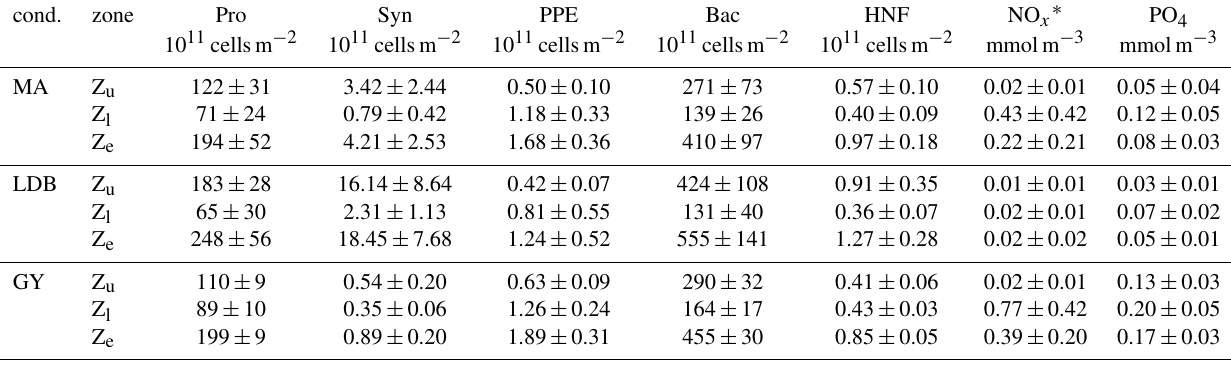
Table 1. Summary of average depth-integrated abundances for Prochlorococcus (Pro), Synechococcus (Syn), picophytoeukaryotes (PPE), and bacteria (Bac), in addition to depth-normalized values of nutrient concentrations (NO x and PO 4 ), for different vertical zones (Z u , Z l and Z e ) and for individual biogeochemical conditions (cond.: MA, LDB, and GY). ∗ NO 2 + NO 3 . cond.